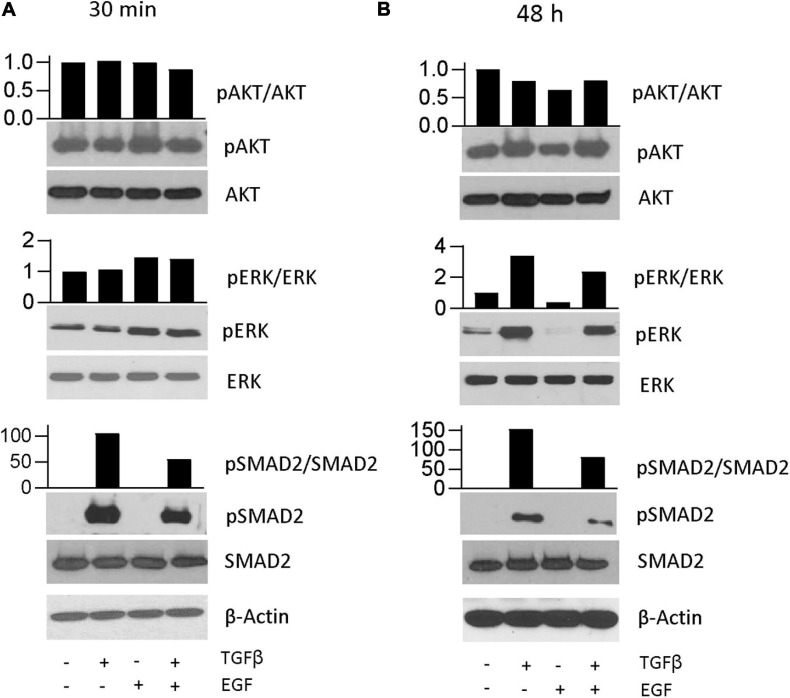
Prolonged phosphorylation of Erk is induced by TGFβ but not EGF. Representative immunoblots of A549 cells (A) 30 min or (B) 48 h after treatment with TGFβ, EGF, or a combination of both. One example and means of densitometry data normalized to control from three experiments are shown. Beta actin was used as a control for equal sample loading. Scans of uncropped immunoblots of all three replicates are shown as Supplementary Data.